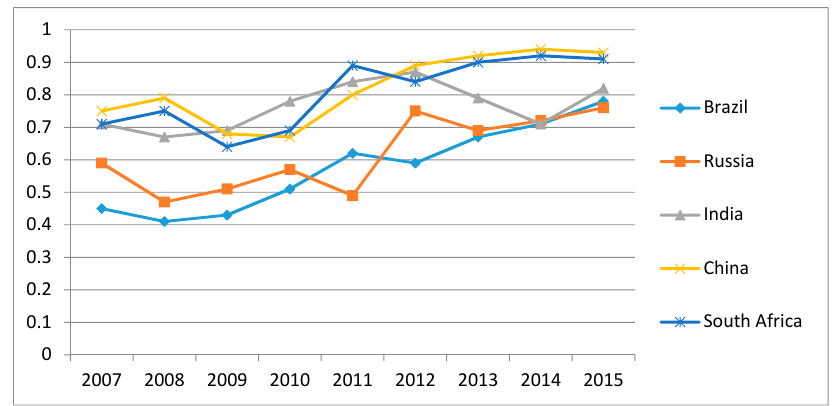
Figure 1. Average cost-efficiency scores of banks within each sample country.